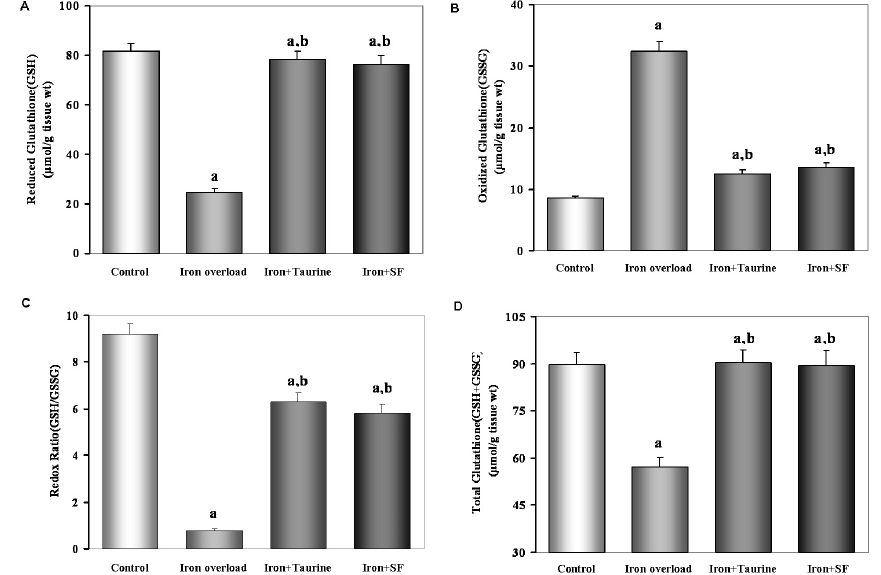
Figure 3. The effect of TAU or SF on hepatic GSH ( A ) and GSSG ( B ) levels, the ratio of GSH/GSSG ( C ) and the total amount GSH + GSSG ( D ) in iron-overloaded mice. Data represents mean ± SE of 12 independent experiments. a: p < 0.01, vs. control group; b: p < 0.01, vs. iron overload group.